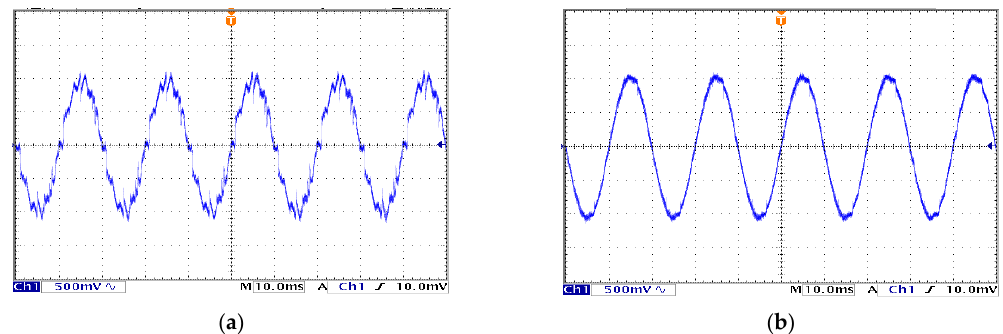
Figure 16. Current waveform in the PV micro-grid. ( a ) Load side current waveform. ( b ) PCC side current compensated waveform.